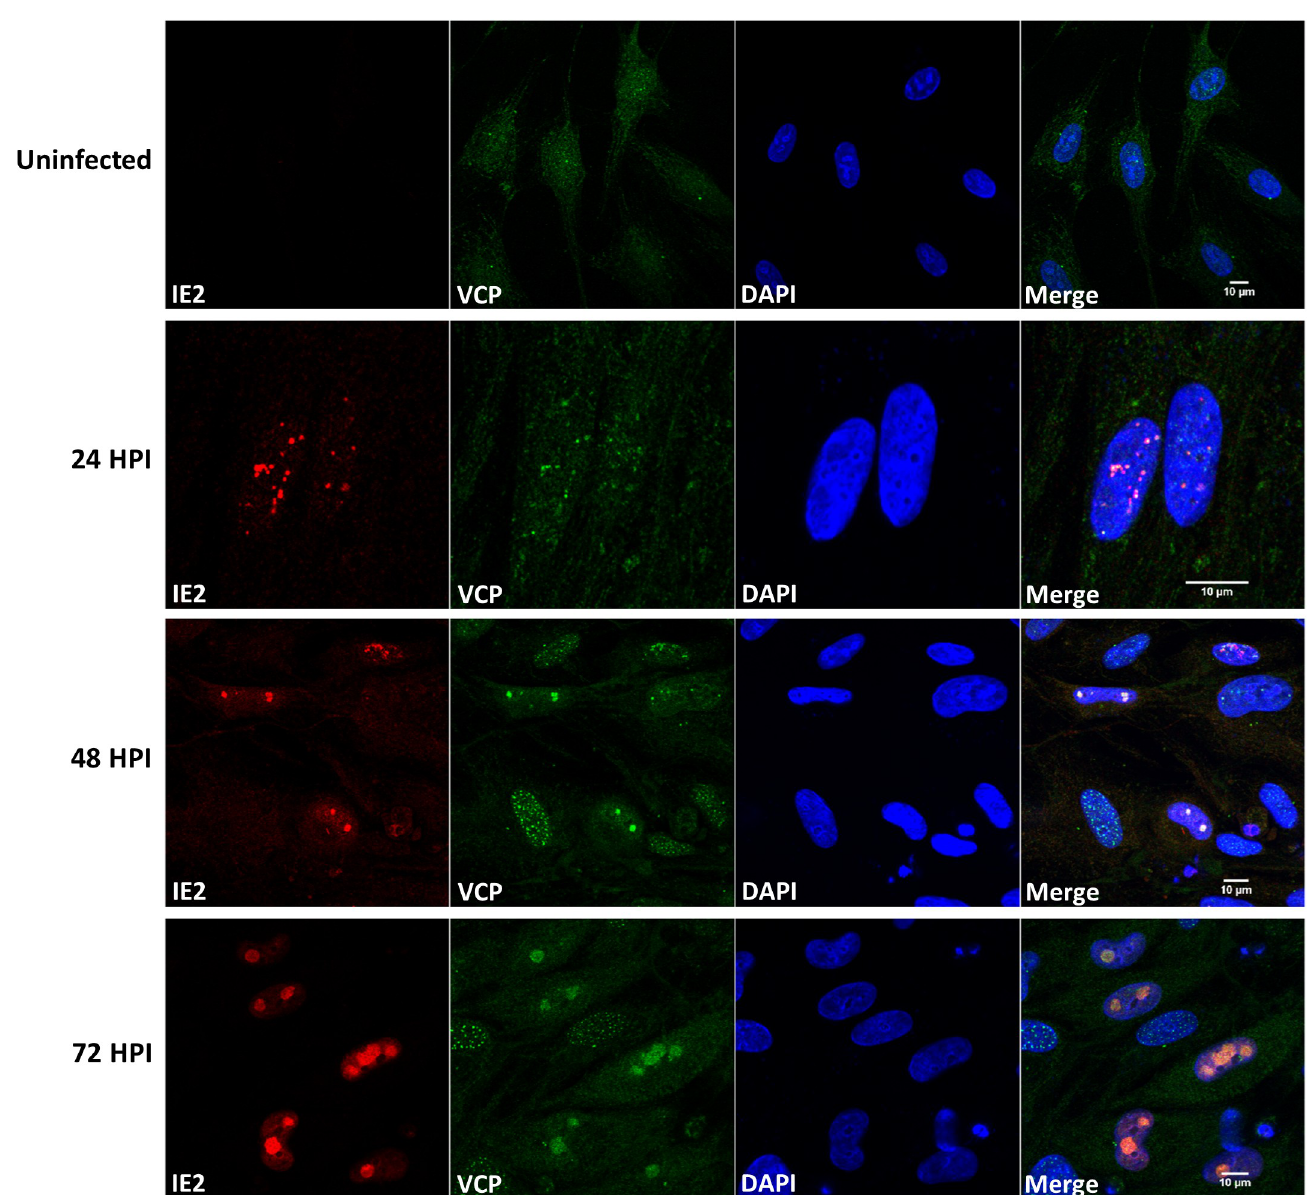
Fig 9. VCP colocalises with viral replication compartments in the nucleus. The cellularlocalisation of VCP was determined by confocal microscopy duringHCMV infection. Cells were infected at high MOI and fixed at 24, 48 and 72 HPI and co-stainedfor VCP and IE2. Nuclei are stained with